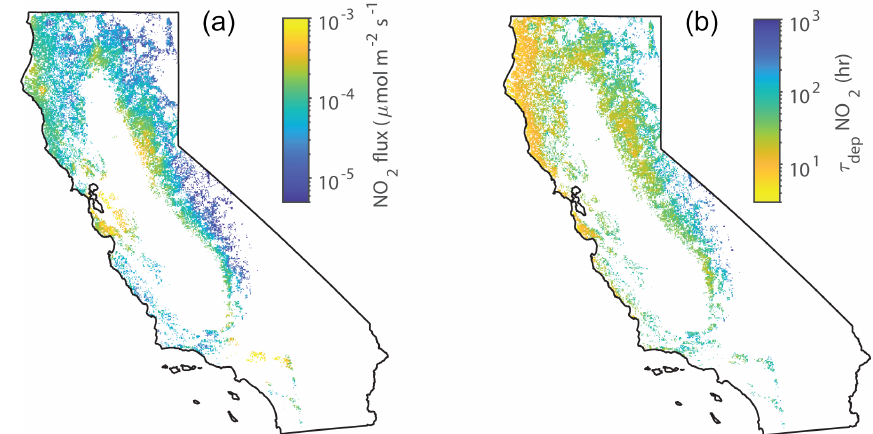
Figure 7. (a) Average midday deposition fluxes of NO 2 to forests in June throughout California. (b) Average midday deposition lifetimes of NO x in June throughout California. White areas are non-forested